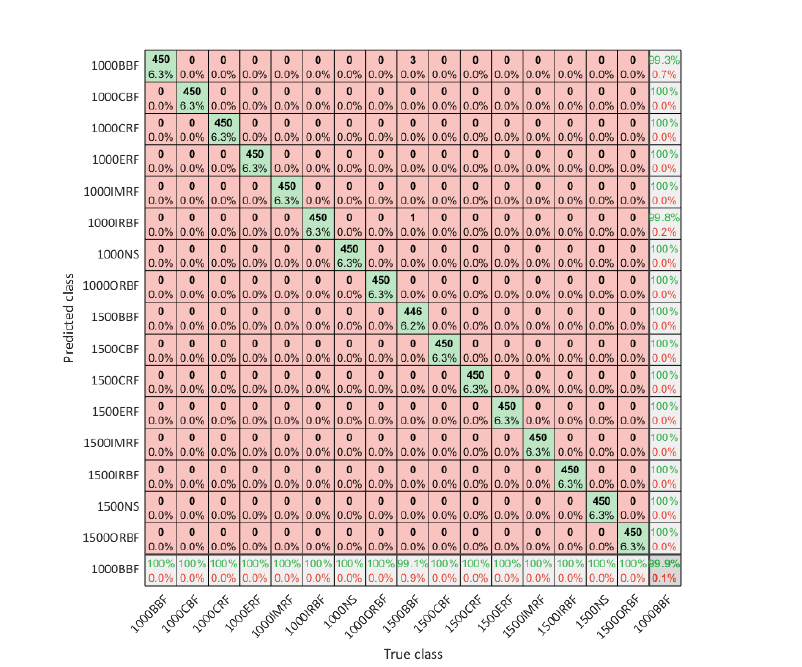
Figure 7. The confusion matrix for 16 predicted classes across the true class with 7200 evaluation